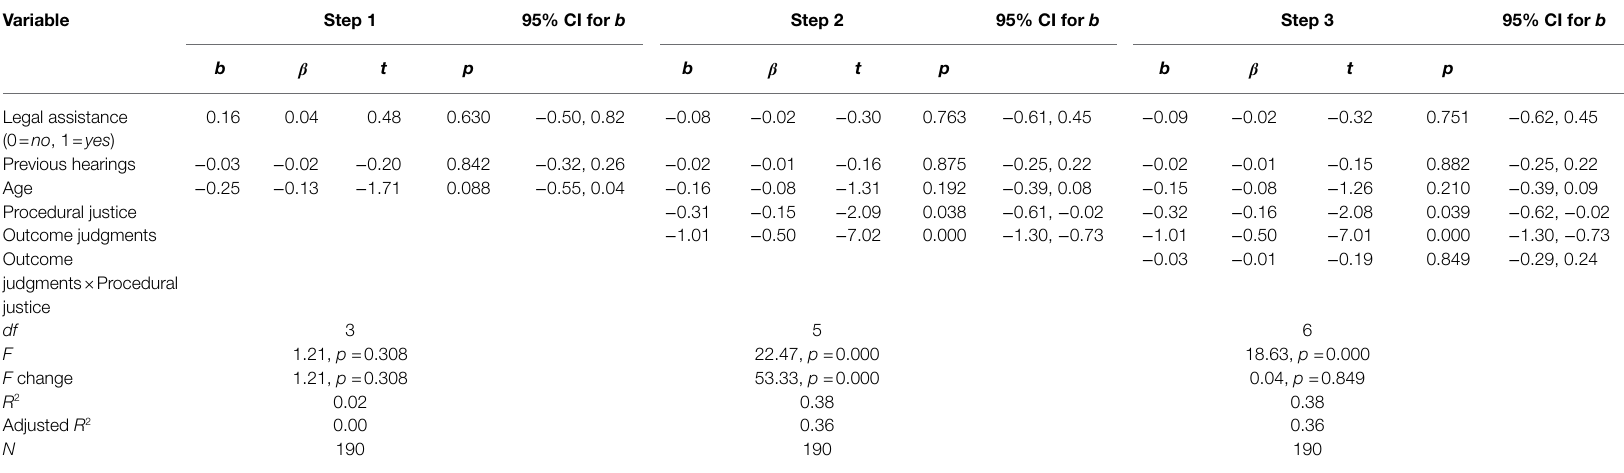
TABLE 12 | Regression results for procedural justice, outcome judgments, and their interaction on protest intentions.